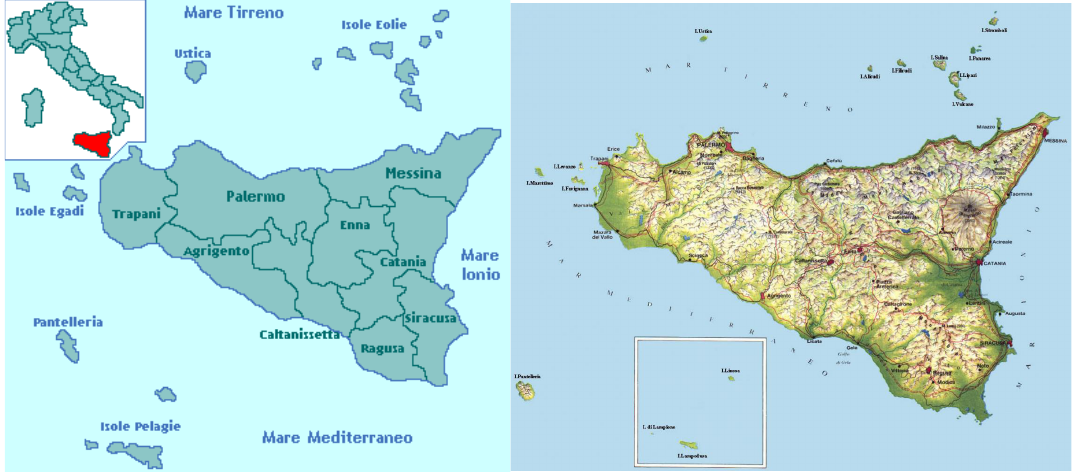
Figure 1. Geographical frame and orography of Enna and Siracusa